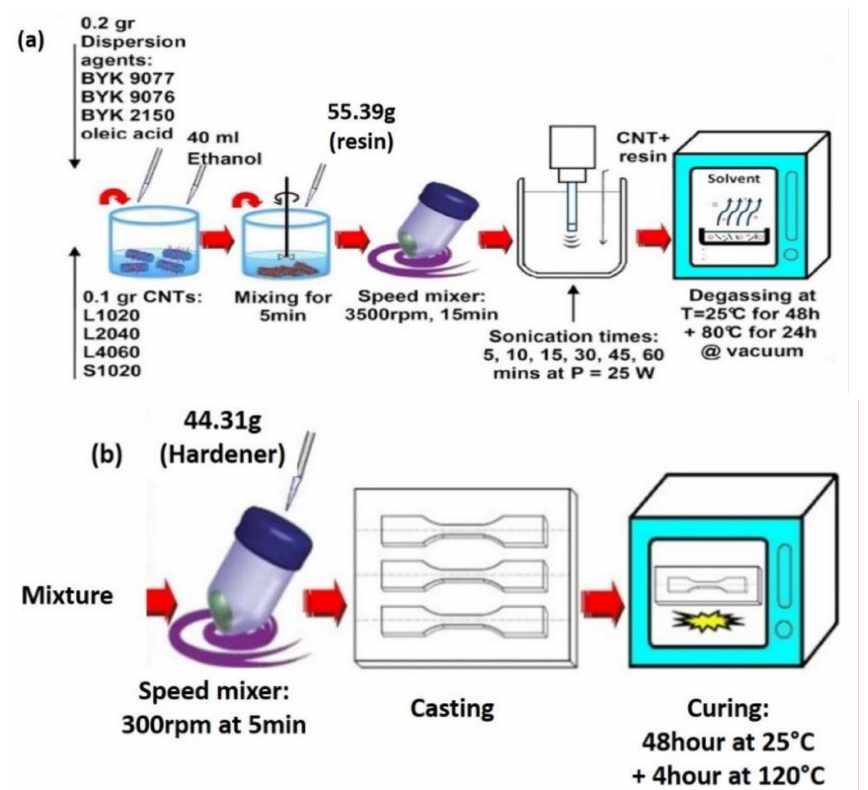
Figure 4. Schematic diagram of the fabrication process for the CNT–epoxy composites: ( a ) prepara- tion of CNT suspension and ( b ) preparation of CNT–epoxy composite. Adapted from